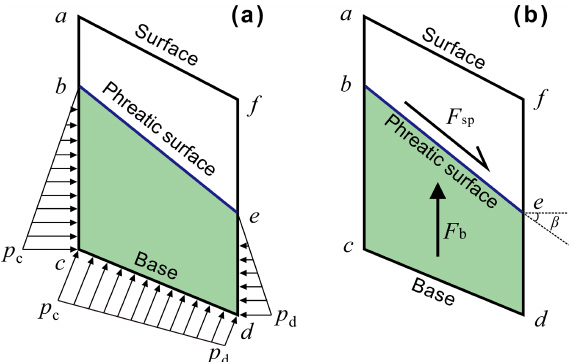
Figure 5. Two equivalent ways to display the water force acting on a slice of the slide mass. (a) Expressed by pore water pressure, (b) expressed by the seepage force F sp and the buoyancy force F b